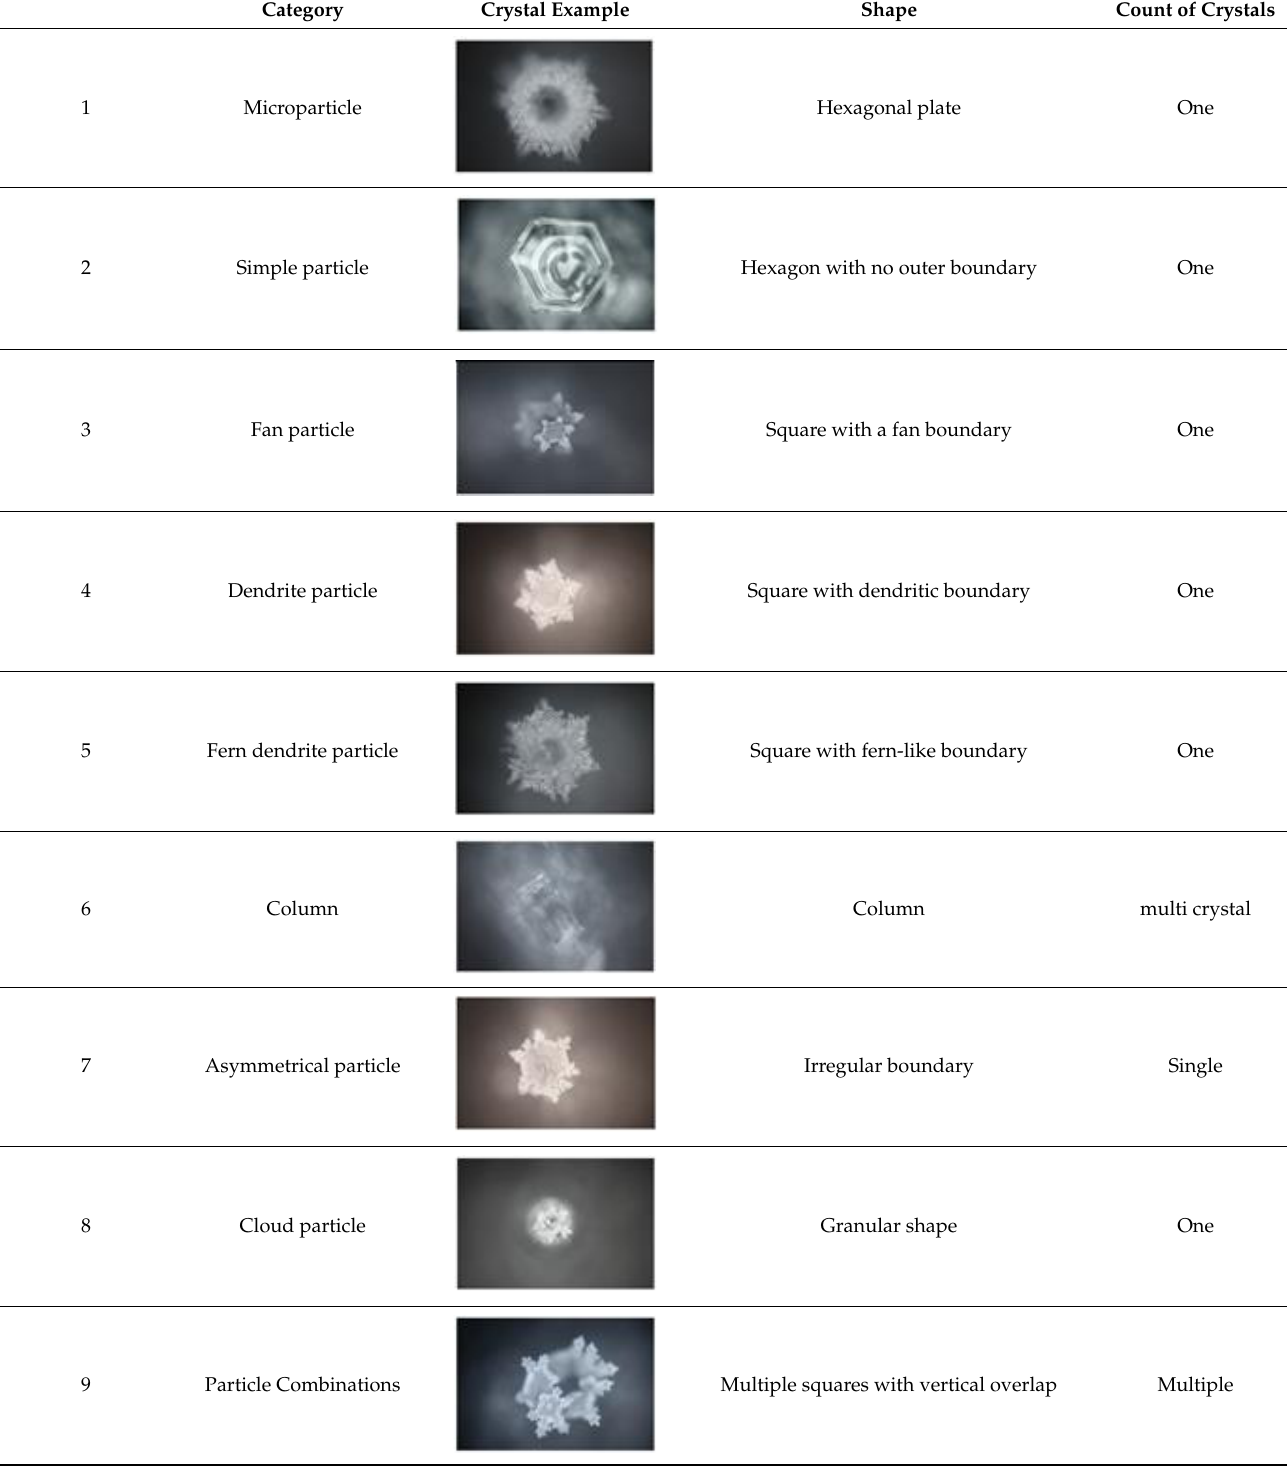
Table 2. Water crystal solid-state classes as defined in [16,17].